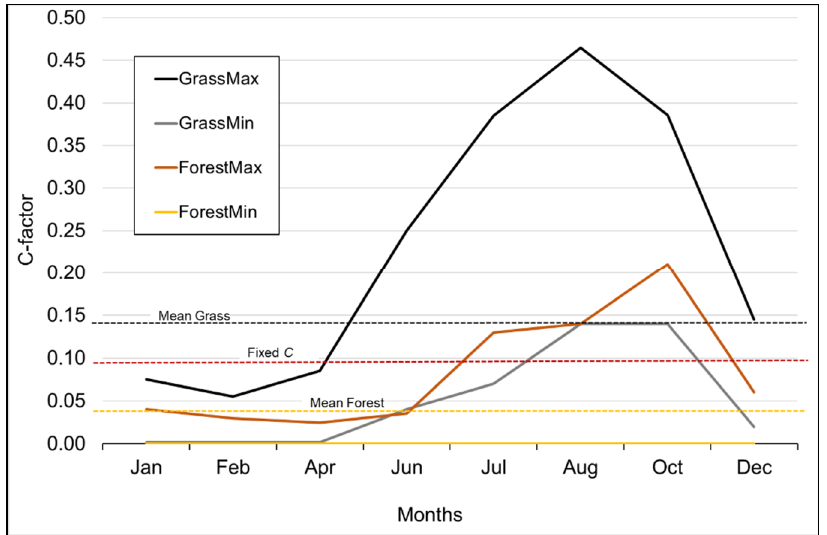
Figure 4. Monthly C factor distribution of the grass and forest vegetation classes in the T35C catchment for the year 2016 calculated from NDVI.